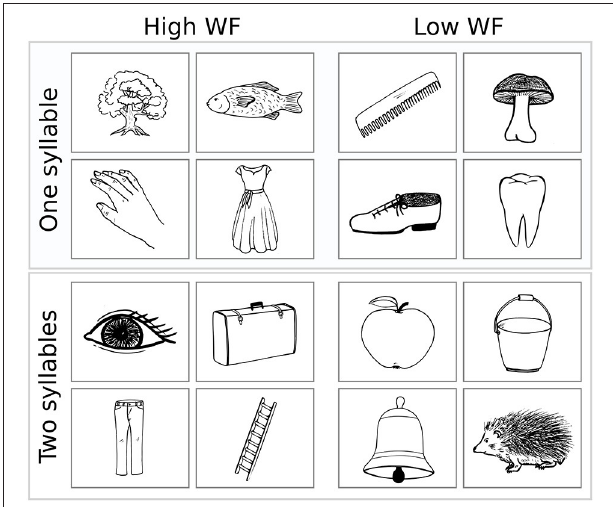
FIGURE 1 | Example stimuli. Four example drawings are given for class A (upper left) to D (lower right). WF, Word frequency.